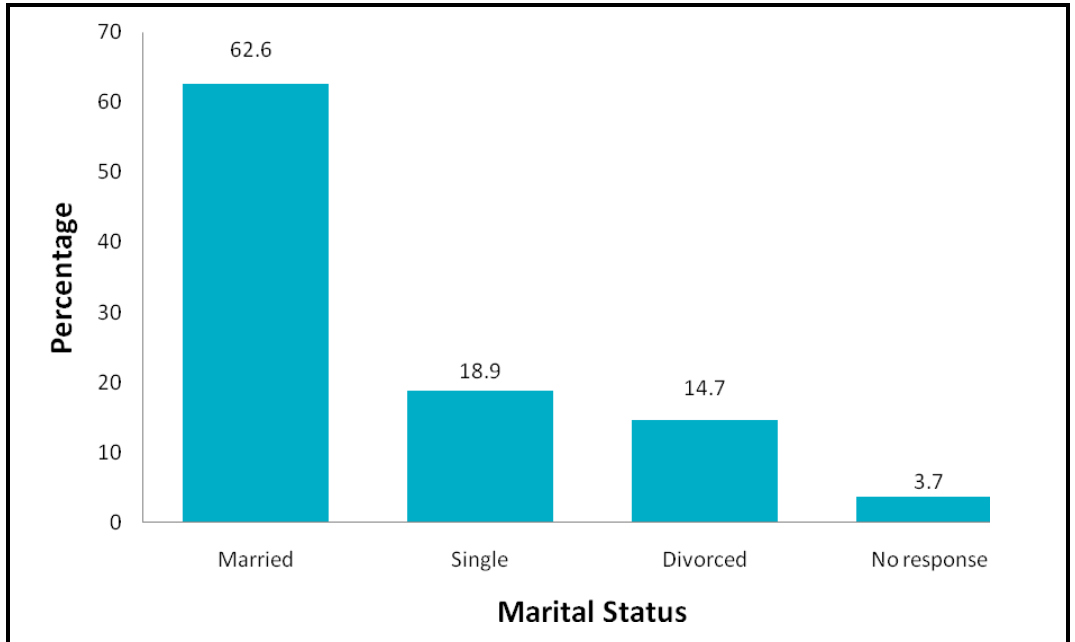
Figure 6. Marital status of respondents.